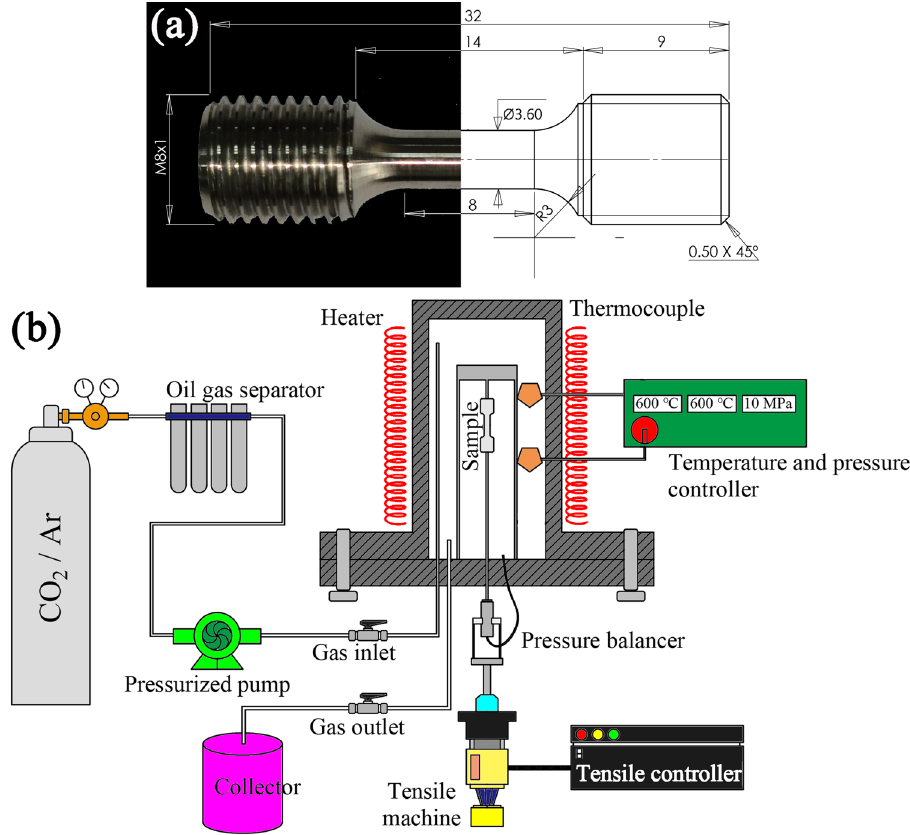
Fig. 15 Schematic diagram. a The tensile sample, b the SSRT autoclave system.